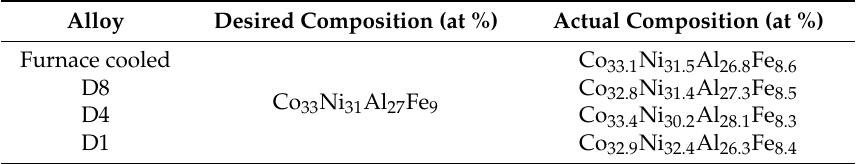
Table 2. The difference between the desired composition and the actual composition of the sample. Alloy